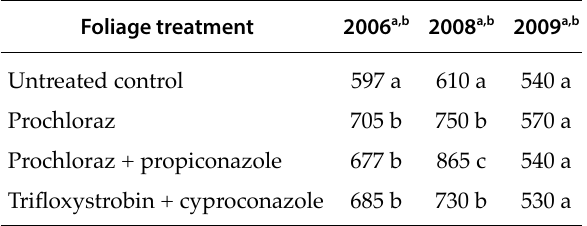
Table 5. Mean grain yields (kg ha -1 ) from wheat plots treat - ed with different fungicides during three growing seasons.